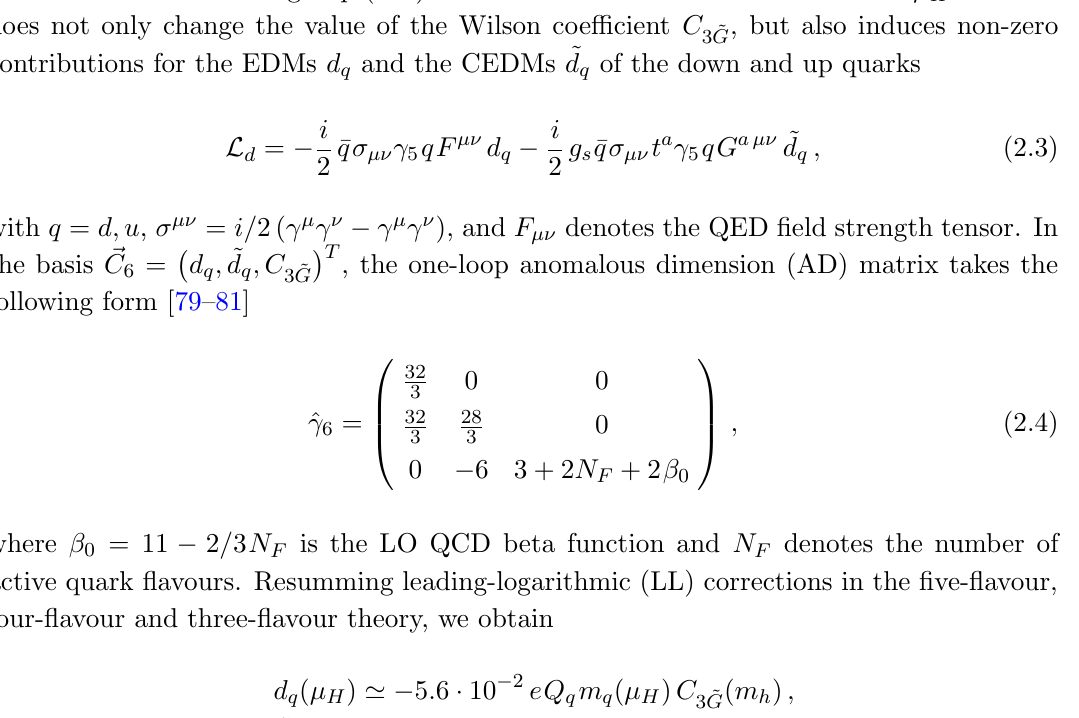
arising from the insertion of C 4 ~ G; 1